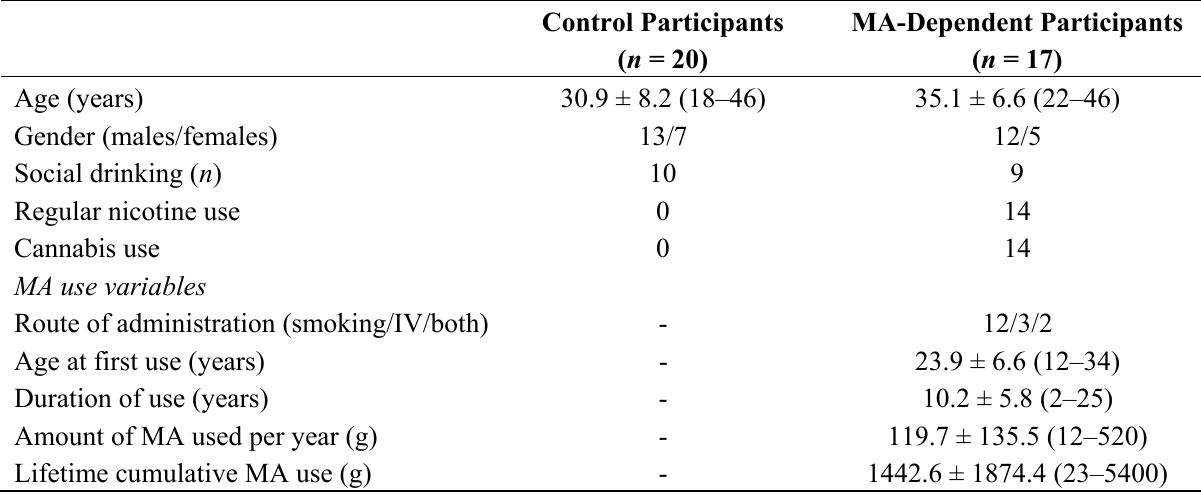
Table 1. Mean ± SD (range) for demographic characteristics of